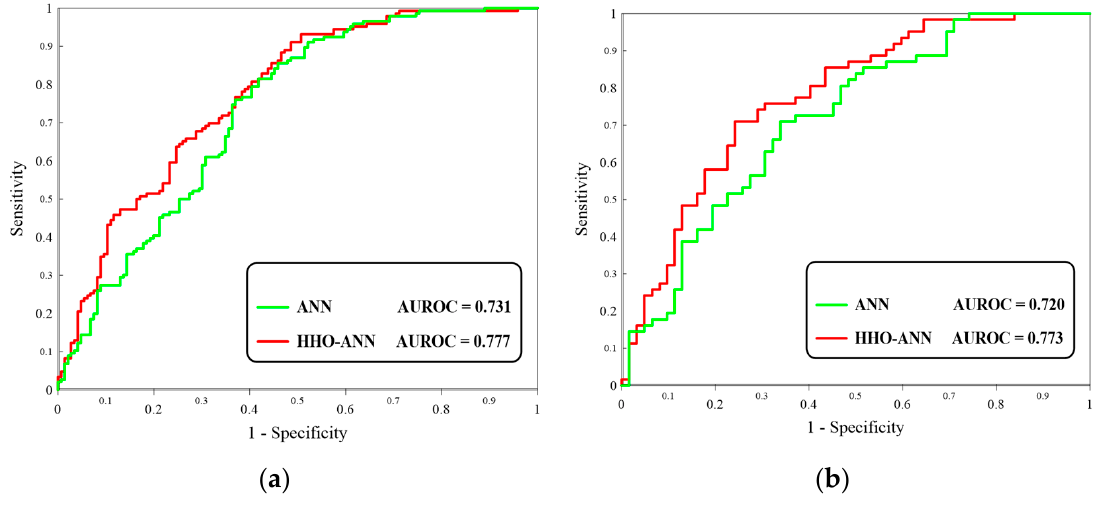
Figure 9. The ROC curves plotted for the ( a ) training and ( b ) testing datasets. Table 2. The statistical analysis of the testing AUROC.